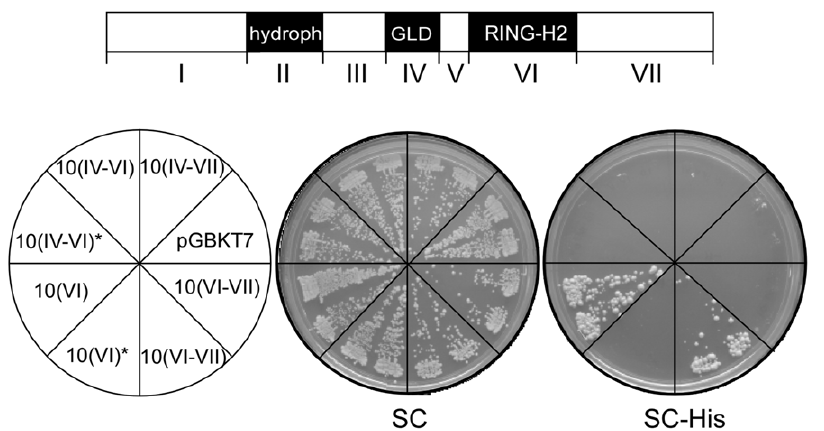
Figure 10. The ATL10 RING-H2 domain interacts with the ubiquitin-conjugase UBC11. Representative plates showing yeast two-hybrid interactions between UBC11 and ATL10 clones carrying the RING-H2 domain. A scheme of the seven regions in ATL10 is shown above as a guide. The left panel shows the template of the plates. ATL10-containing fragments were ligated into the DNA-binding domain vector pGBKT7 and UBC11 was recombined into the activation domain of pHOST pACT2 Lox vector; description ATL10 segments is shown in Figure 7, region IV corresponds to GLD, region VI to the RING-H2 domain and the asterisk to a mutated RING-H2 domain. The yeast two-hybrid assay was performed as in Figure 8, except that transformants were then streaked onto SC medium lacking Trp and Leu (SC), into SC medium lacking Trp, Leu, and His, and onto SC medium lacking Trp, Leu, His, and Ade. No growth was observed after 7 days of incubation on SC medium lacking Trp, Leu, His, and Ade; this plate is not